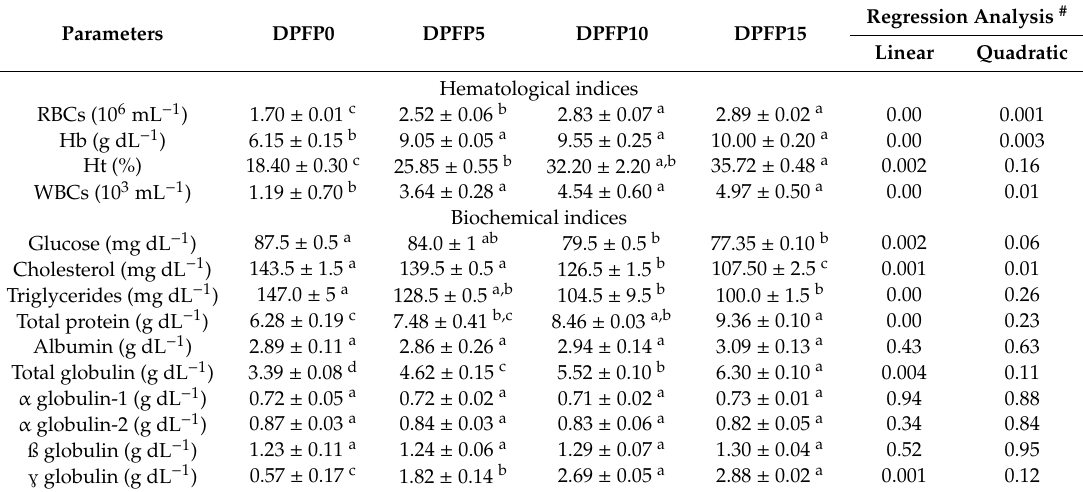
Table 4. The e ff ects of dietary doum palm fruit powder (DPFP) on the hematological and serum biochemical indices of African catfish.